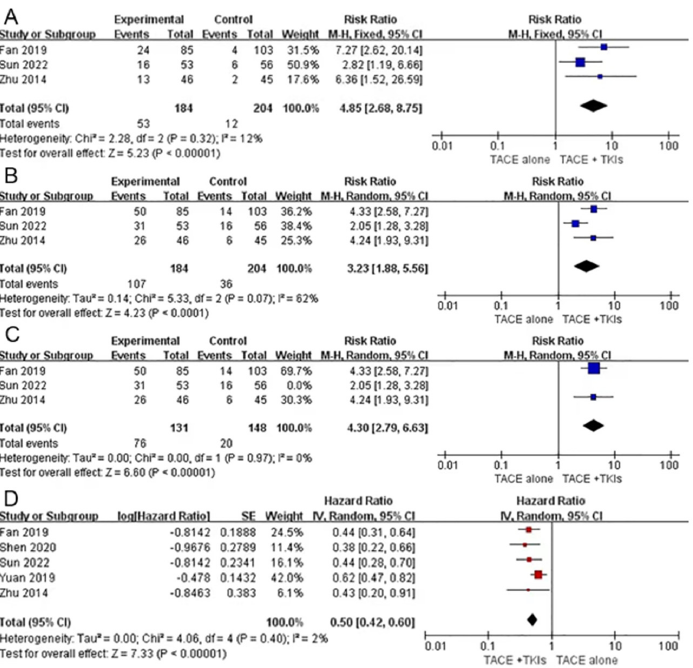
Figure 2. Forest plots of tumor response and overall survival for combination therapy vs. monother- apy. Outcomes: ( A ): objective response rate (ORR); ( B ): disease control rate (DCR); ( C ): sensitivity analysis; ( D ): overall survival (OS). TACE: transarterial chemoembolization; TKIs: tyrosine kinase inhibitors